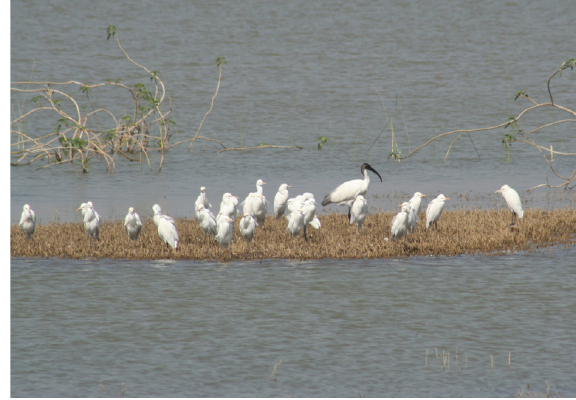
Image 3. Black-headed Ibis Threskiornis aethiopica